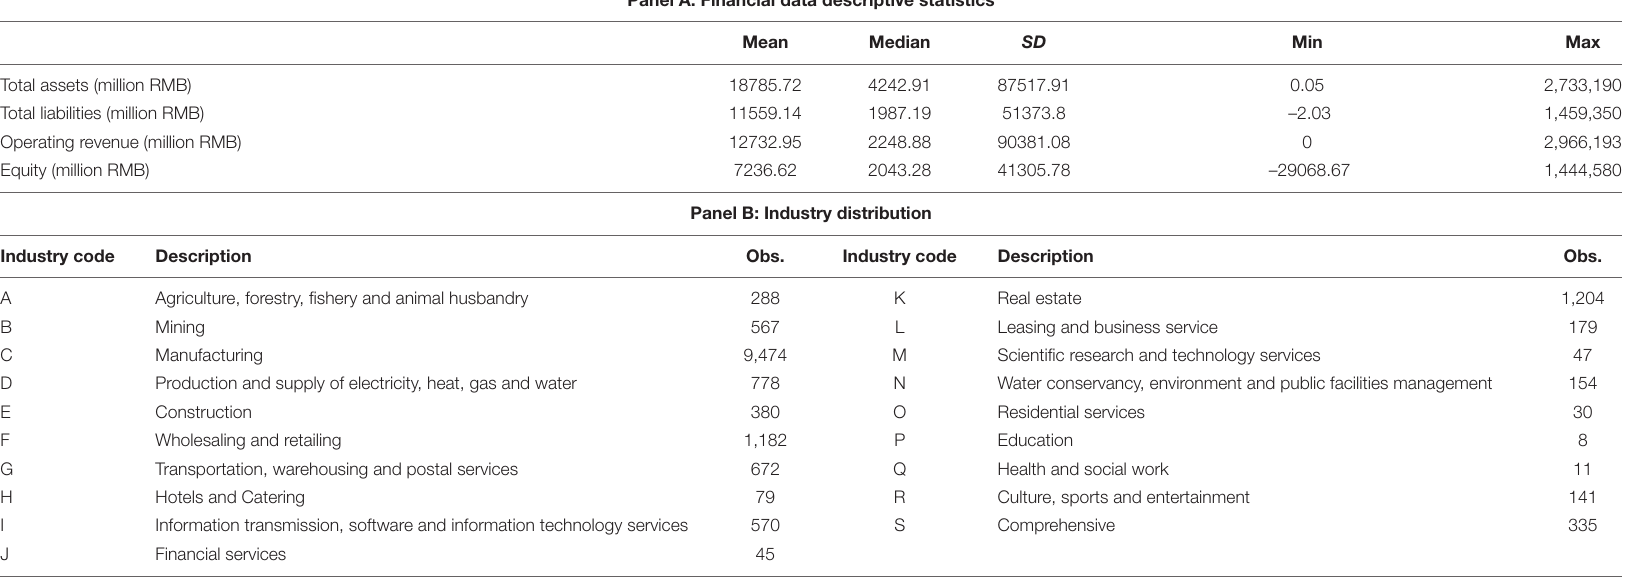
Panel A: Financial data descriptive